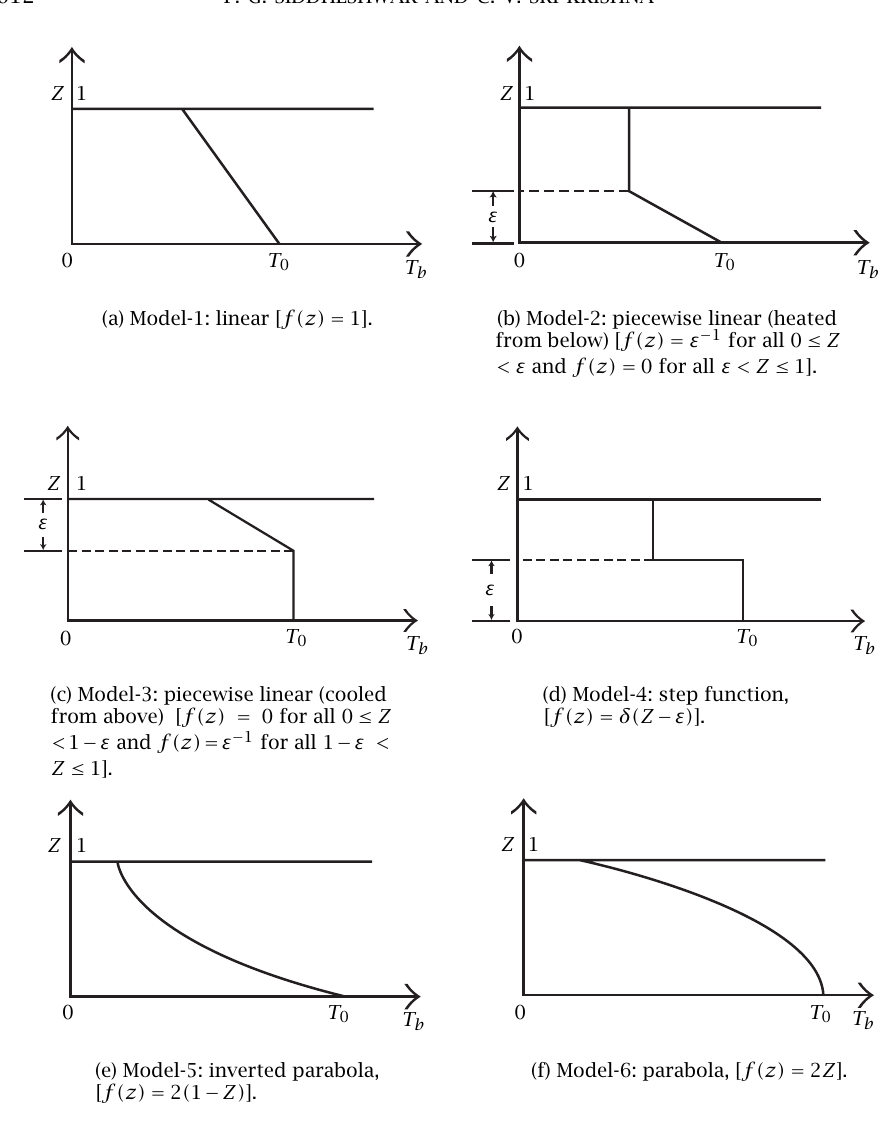
Figure 2.1 . Basic state temperature profiles ( ε = thermal depth) ( − d/ ∆ T